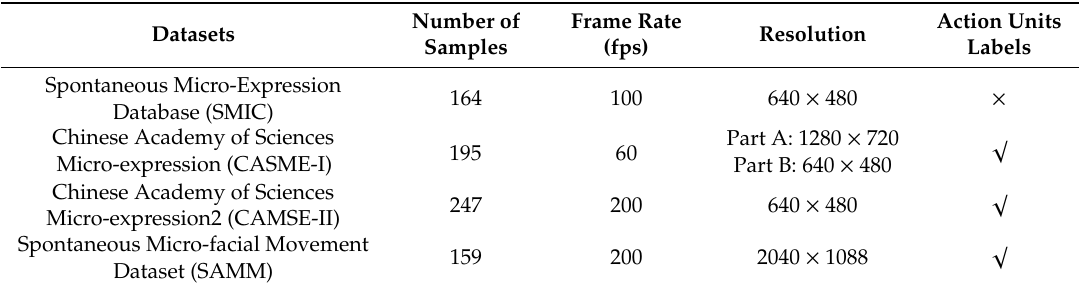
Table 1. Detailed attributes of micro-expression (ME)